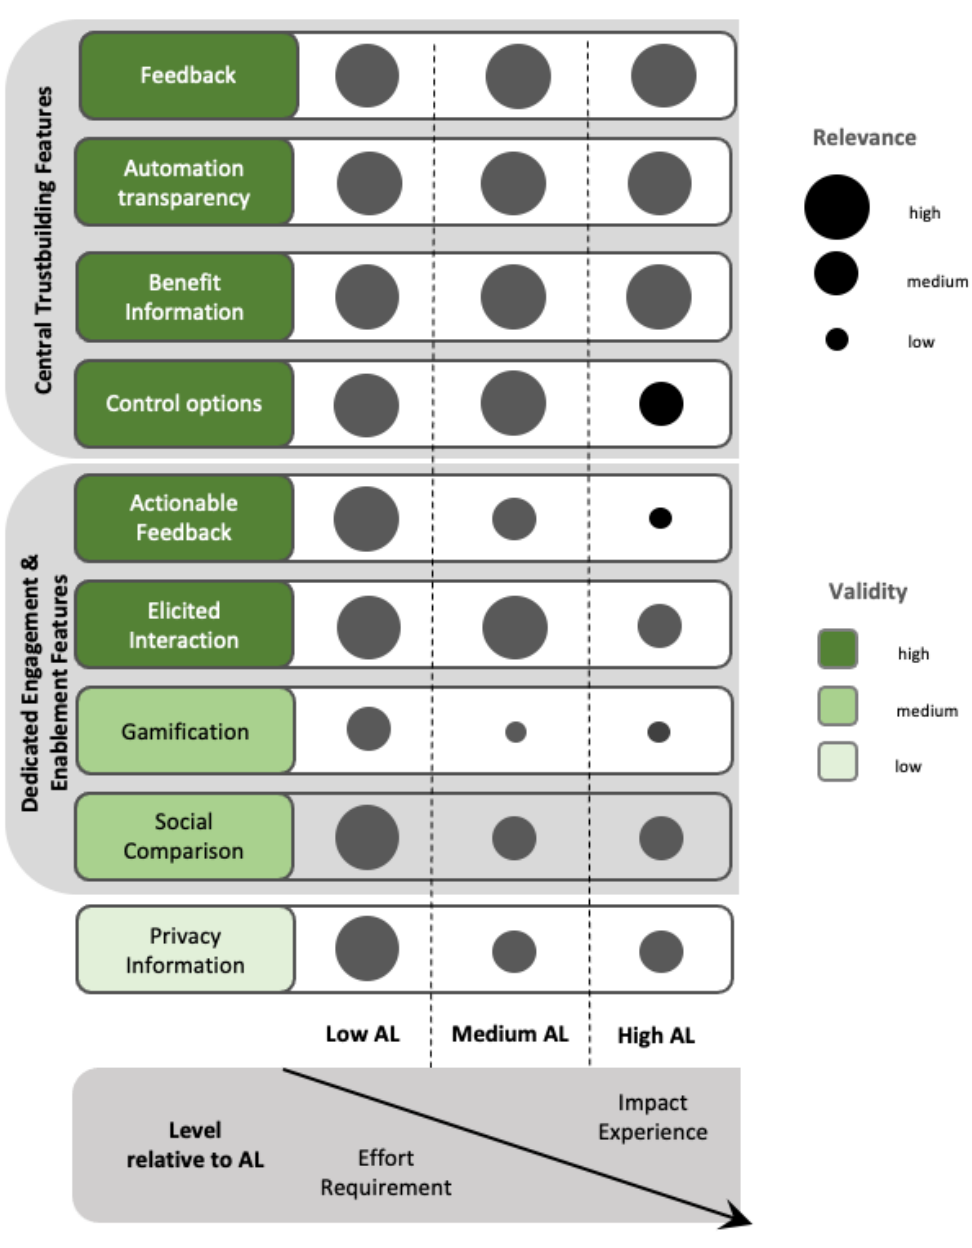
Figure 7. Overview of the DSM trust